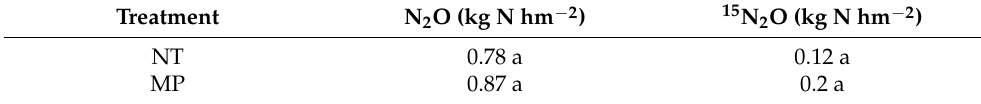
Table 2. The growing season emission of N 2 O and fertilizer 15 N 2 O under different tillage practices. Treatment